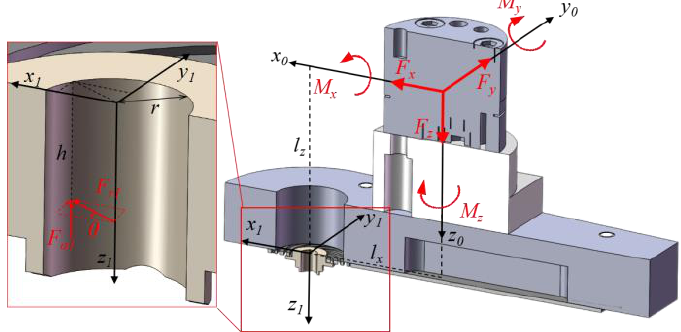
Figure 3. Sectional view of TMP component and